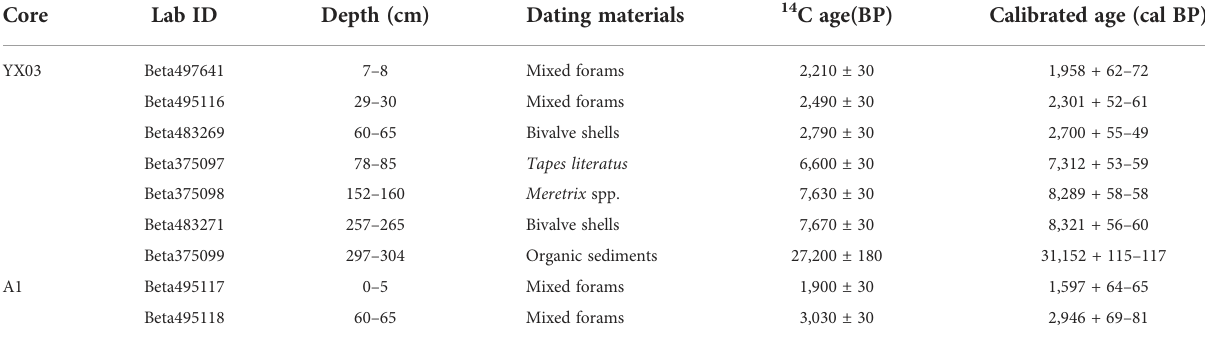
TABLE 1 14 C-AMS dates of cores YX03 and